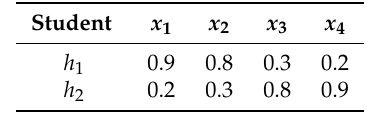
Table 3. Grades obtained by the students in Example 5 in the individual